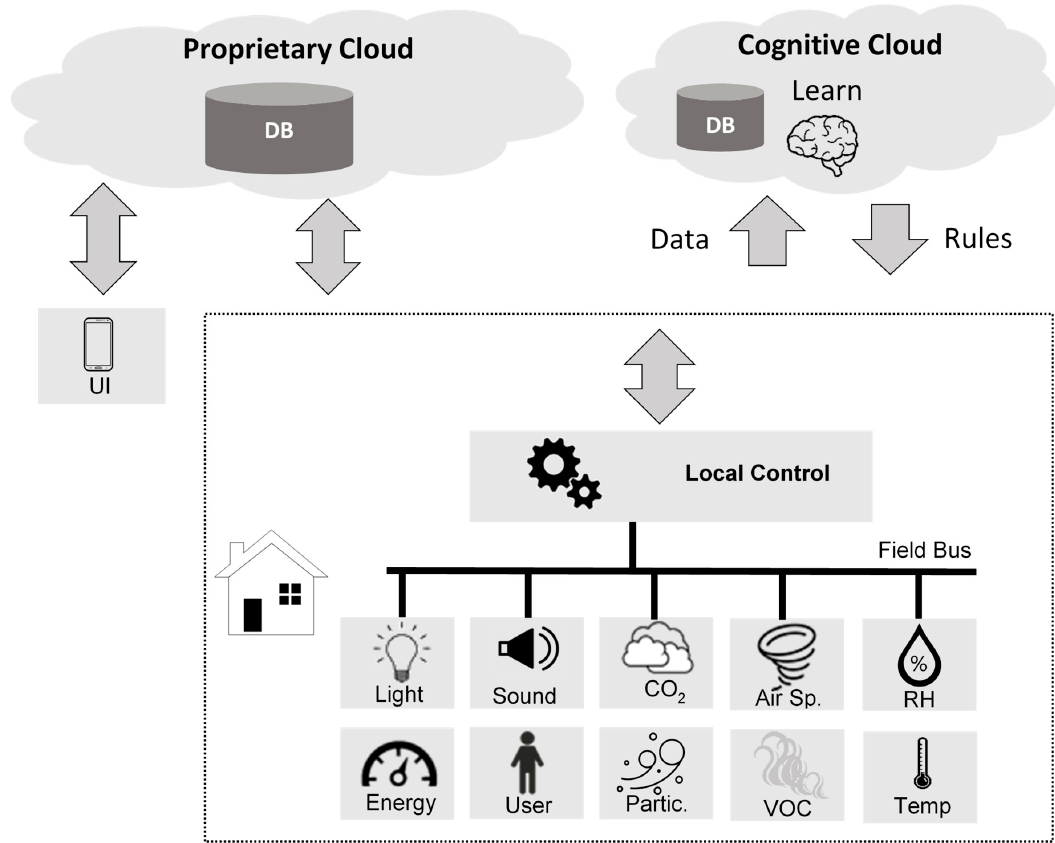
Figure 4. The block diagram of the information and communication technology (ICT) architecture proposed in the ELISIR